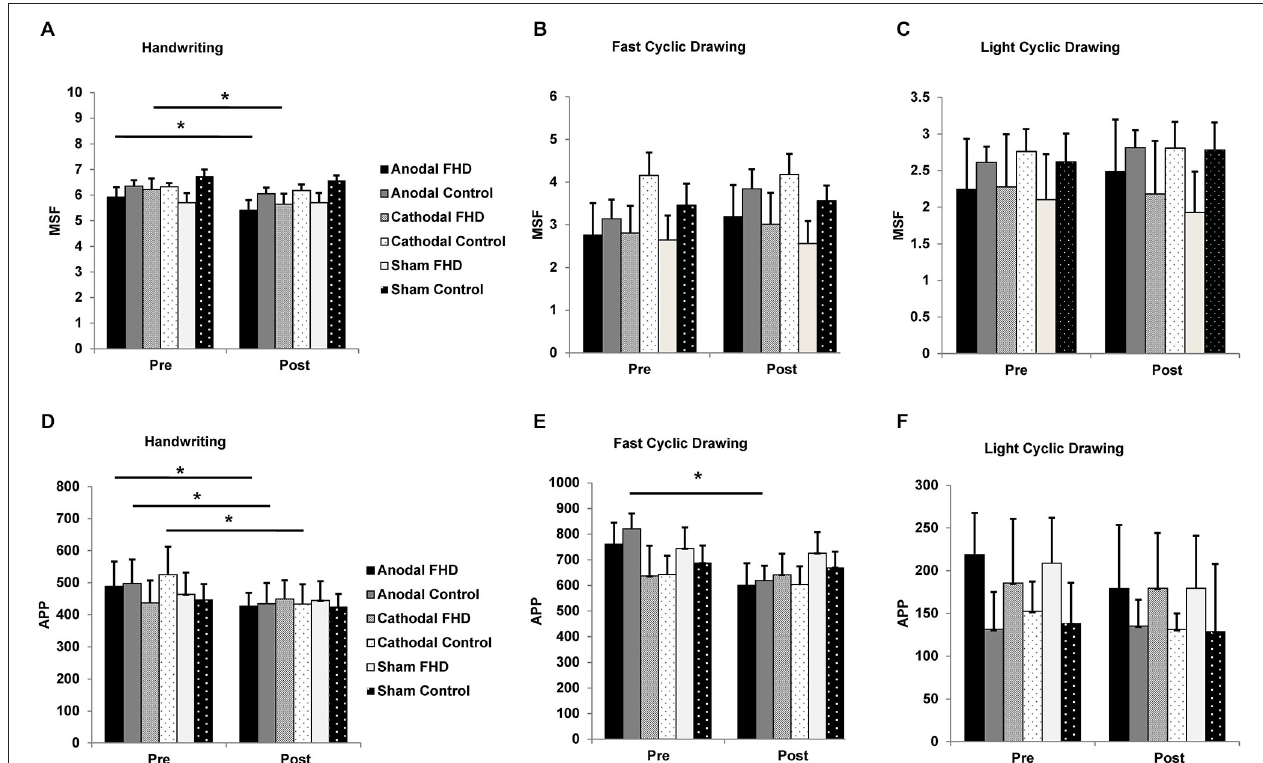
pressure during handwriting was reduced by anodal tDCS in both groups and by cathodal tDCS in the control group. (E) Average pen pressure was reduced during fast cyclic drawing in both groups, although only the control group reached statistical significance. (F) Average pen pressure in the light cyclic drawing task was unchanged by tDCS. Significance at P < 0.05 is signified by